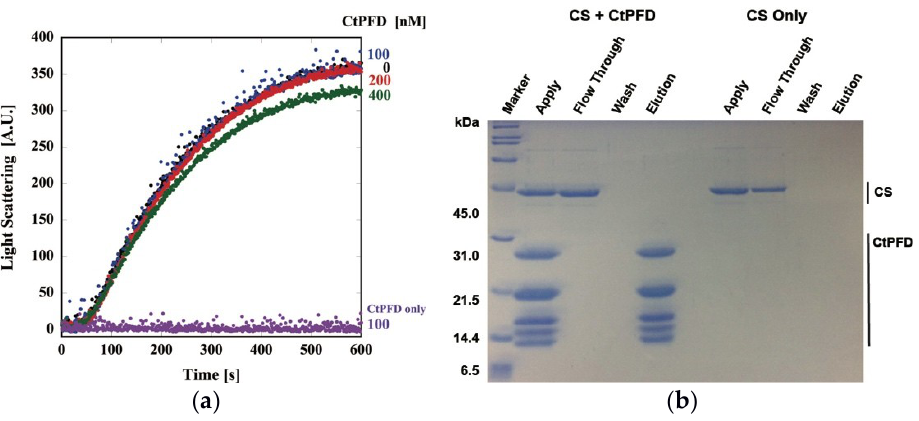
Figure 4. Analysis of CtPFD interaction with denatured CS. ( a ) Effect of CtPFD on the thermal aggregation of CS. ( b ) SDS-PAGE of the pull-down assay for the interaction between StrepTrap HP-immobilized CtPFD and denatured CS.